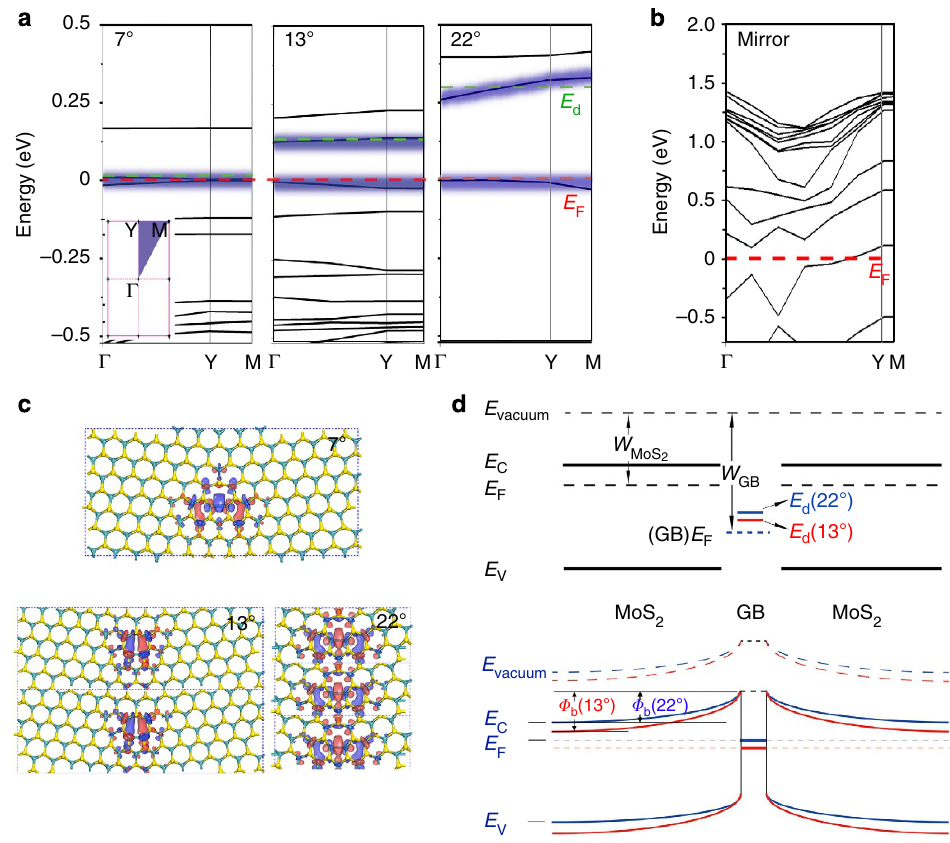
Figure 4 | DFT calculations of the band structure for GBs with various misorientation angles. Band structure near the Fermi level (red dash line) of ( a ) tilt and ( b ) mirror GBs. Inset shows the first Brillouin zone. The first band above the Fermi level is highlighted by a green-dashed line. ( c ) The charge densities for the first band above the Fermi level, as indicated by the ‘Down’ type of 5–7 dislocation cores for 7 (cid:2) , 13 (cid:2) and 22 (cid:2) . ( d ) The expected flat band alignment near the GB with defect states extracted from the band structures and the corresponding band bending after Fermi level equilibrium. The Schottky barrier height decreases in response to a